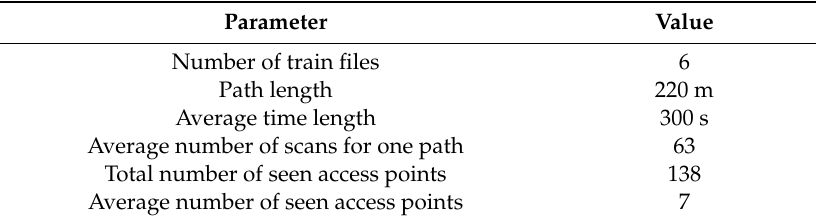
Table 3. Data for training the Wi-Fi fingerprinting